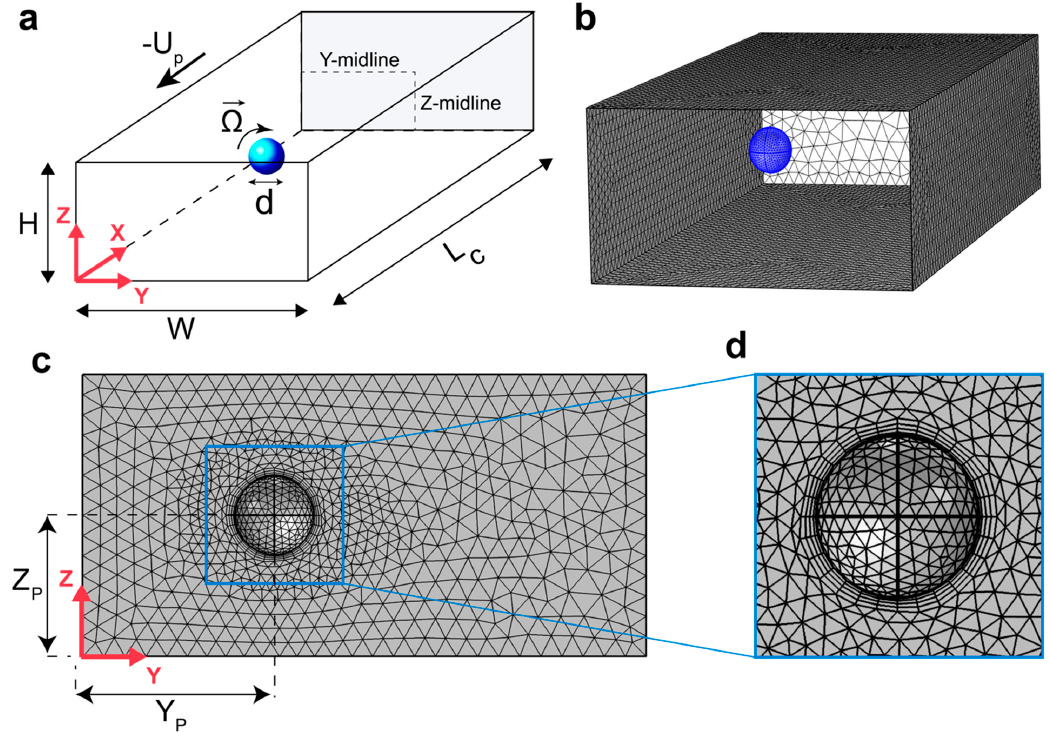
Figure 2. Model schematics and mesh configuration. ( a ) Simulation box consists of a rectangular duct with the cross-sectional dimensions W = 50 µm, H = 25 µm and length of L C = 150 µm; channel walls move with the speed of − U p while the particle has angular velocity vector of Ω . ( b ) Domain mesh (inlet and interior mesh are hidden for easier visualization) ( c ) cross-section mesh. Y P and Z P are the distance of the particle from the side wall and the bottom wall, respectively. ( d ) Finer mesh on the particle surface and boundary layer mesh surrounding the particle.